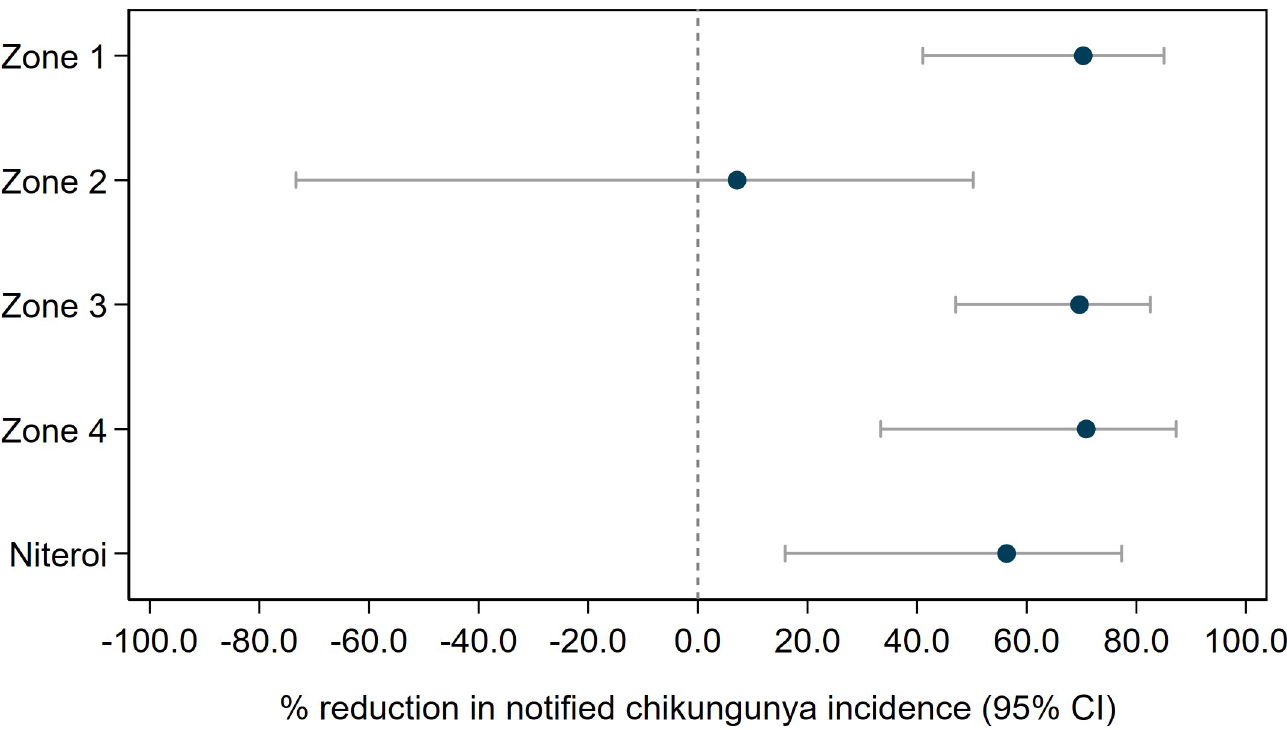
Fig 8. Estimated reduction in the incidence of chikungunya following Wolbachia deployments in Nitero´i, in each release zone individually and in the aggregate release area. Point estimates (circles) and 95% confidence intervals (horizontal bars) from controlled interrupted time series analysis of monthly chikungunya case notifications to the Brazilian national disease surveillance system (Jan 2015 –June 2020).